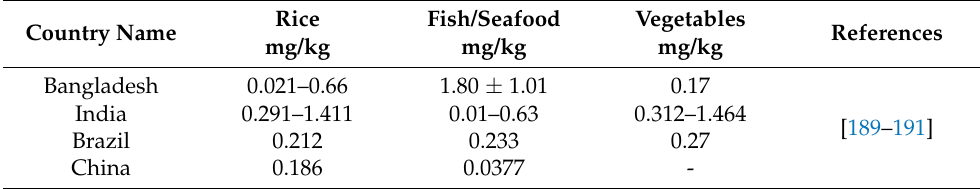
Table 6. Arsenic levels in various foods in different